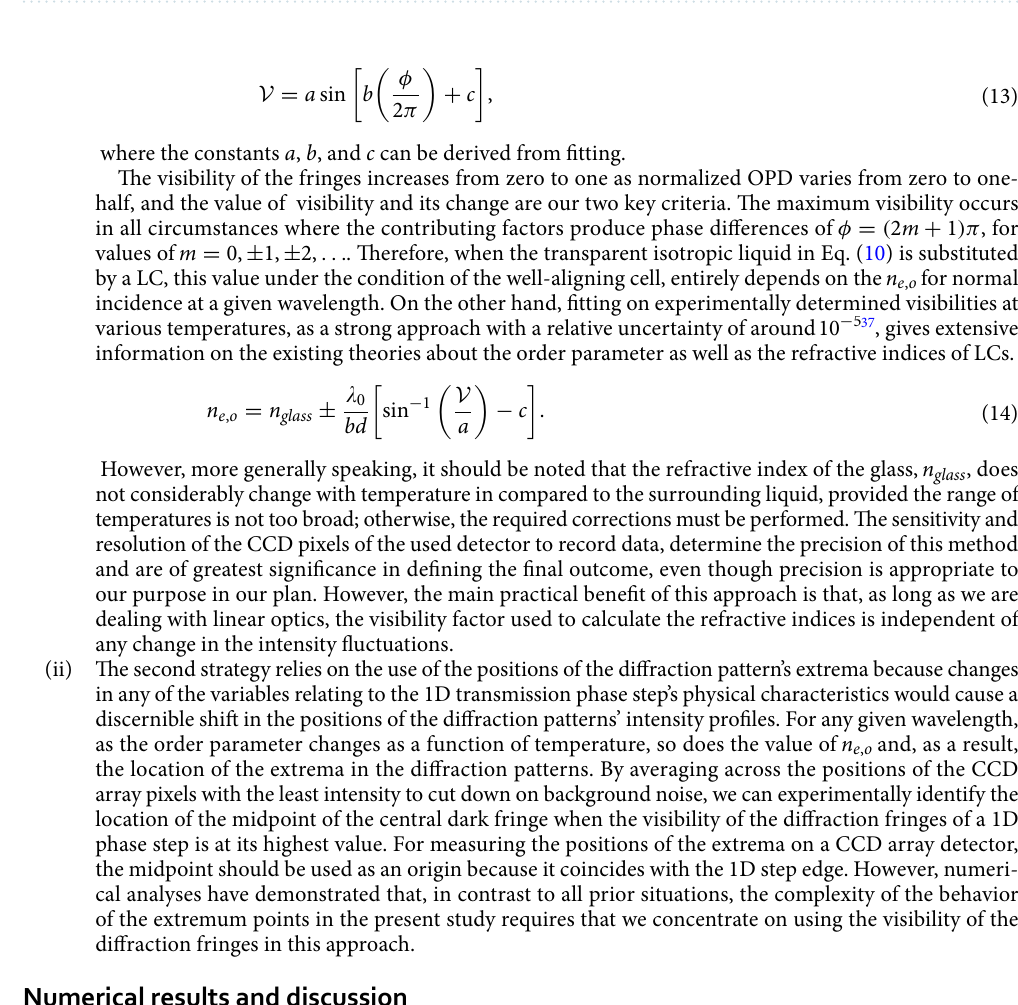
Figure 3. Fringe visibility variation with normalized OPD, (δ/ (cid:31) 0 ) = φ/ 2 π . For both temperature-dependent linear and non-linear variation of OPD, this function has a periodic and symmetrical structure with an axis of symmetry that has reached its maximum at values of φ/ 2 π = ± 1 / 2, ± 3 / 2, . . . and reaches zero at values of φ/ 2 π = 0, ± 1, ± 2, . . .